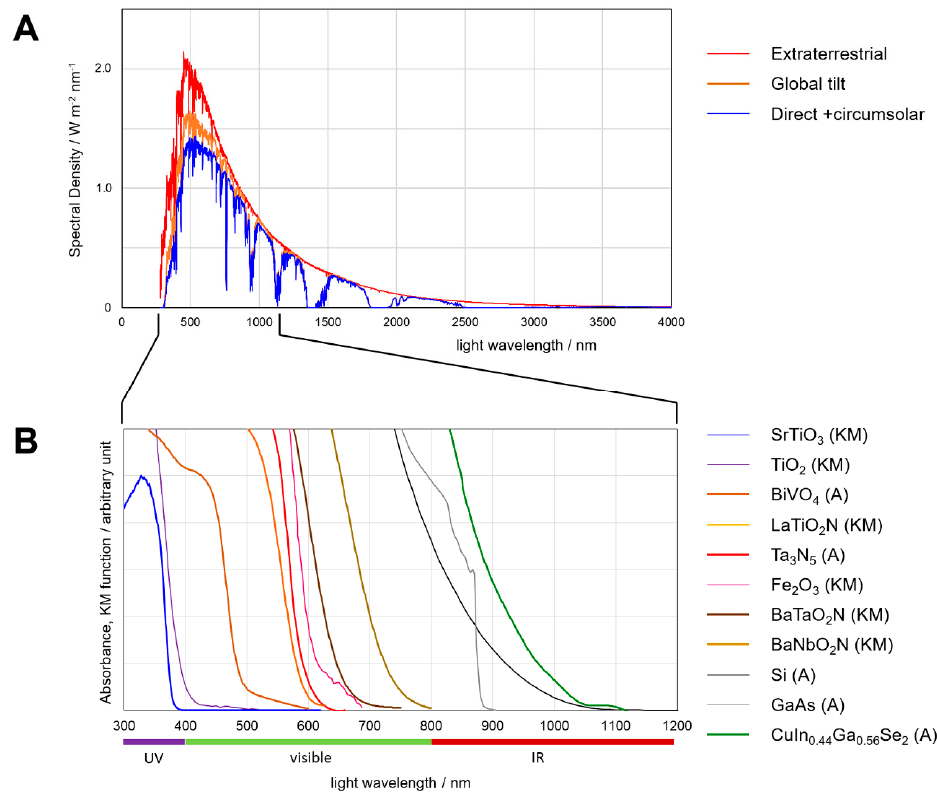
Figure 2. ( A ) Natural solar spectra. “Extraterrestrial” = average radiation at the top of earth atmosphere facing the sun, “Global Tilt” = radiation on a plane at the ground facing the south and tilted by 37 ◦ from horizontal, involving the sun light, atmosphere-scattered light and reflection from the ground, “Direct + Circumsolar” = tracked radiation from the sun on the ground, and scattered light within ± 2.5 ◦ from the center of sun. Global Tilt represents the air-mass 1.5 G (AM 1.5 G) spectrum. The coordinate is given in the absolute areal energetic spectral density in W ∙ m − 2 ∙ nm − 1 . These data are obtained from National Renewable Energy Laboratory, USA (rredc.nrel.gov/solar/spectra/am1.5/ [3]). ( B ) Absorption spectra of inorganic semiconductors, indicated as either the absorption coefficient converted from the transmission spectra (A) or Kubelka-Munk diffuse-absorption function (KM), both arbitrarily normalized to magnify the edge of absorption by each material. The spectral curves were reproduced for SrTiO 3 from [4], TiO 2 [5], BiVO 4 [6], LaTiO 2 N [7], Ta 3 N 5 by our own dedicated measurement, Fe 2 O 3 [8], BaTaO 2 N [9], BaNbO 2 N [10], Si [11], GaAs [12] and CuIn 0.44 Ga 0.56 Se 2 by our own dedicated